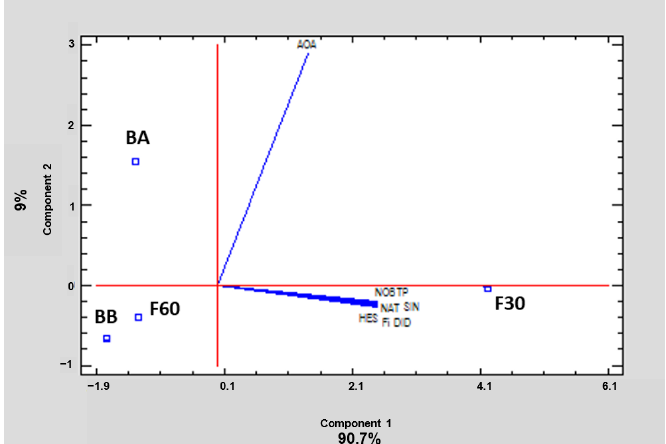
Figure 5. Principal component analysis of total phenols (TP), sum of identified flavonoids (Fi), hesperidin (HES), narirutin (NAT), didymin (DID), nobiletin (NOB), sinensetin (SIN), and antioxidant activity (AOA) of the four polyphenol fractions (codes according to Section 2.2) of orange juice by-product powder.